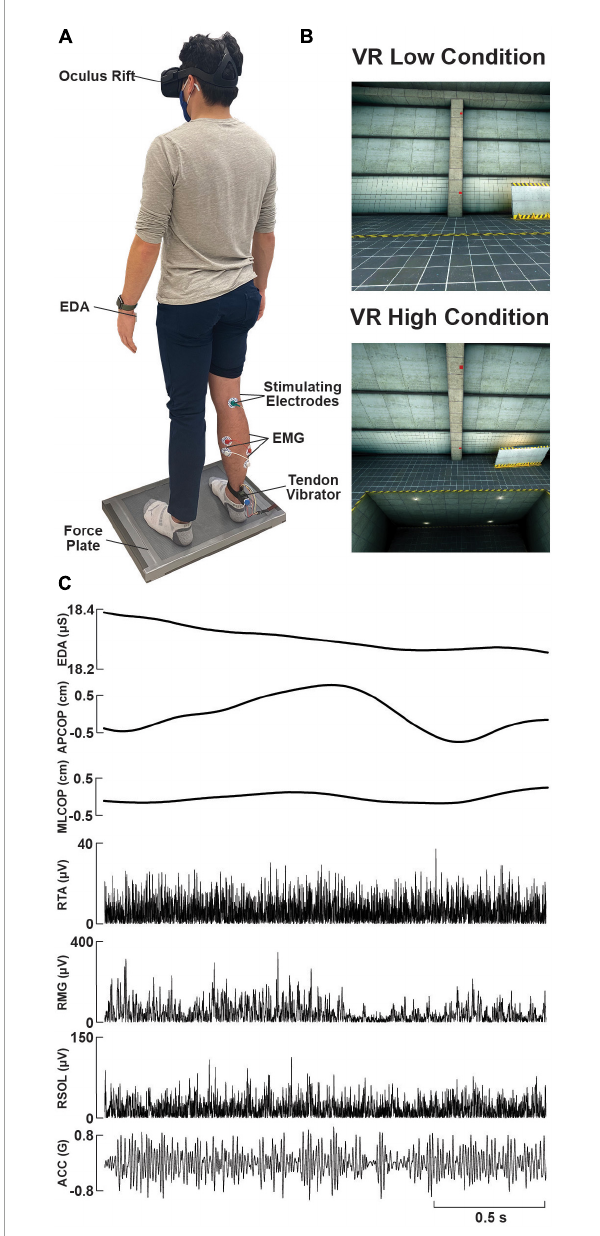
FIGURE1 Experimental setup and raw data. (A) Photo of a participant standing on the force plate, instrumented with a VR headset, lower-limb surface electromyography (EMG) electrodes, tibial nerve electrical stimulation electrodes over the popliteal fossa, a custom-made wearable tendon vibrator over the right Achilles tendon, and electrodermal activity (EDA) electrodes on the left palm. (B) Sample visual environment displayed to participants within the ‘Low’ and ‘High’ (looking down) VR conditions. (C) Raw data traces of EDA, force plate (centre of pressure, COP, in the anterolateral, AP, or mediolateral, ML, planes), rectified EMG (right soleus, RSOL; right medial gastrocnemius, RMG; right tibialis anterior, RTA), and vibrator acceleration (ACC), during an exemplary trial.